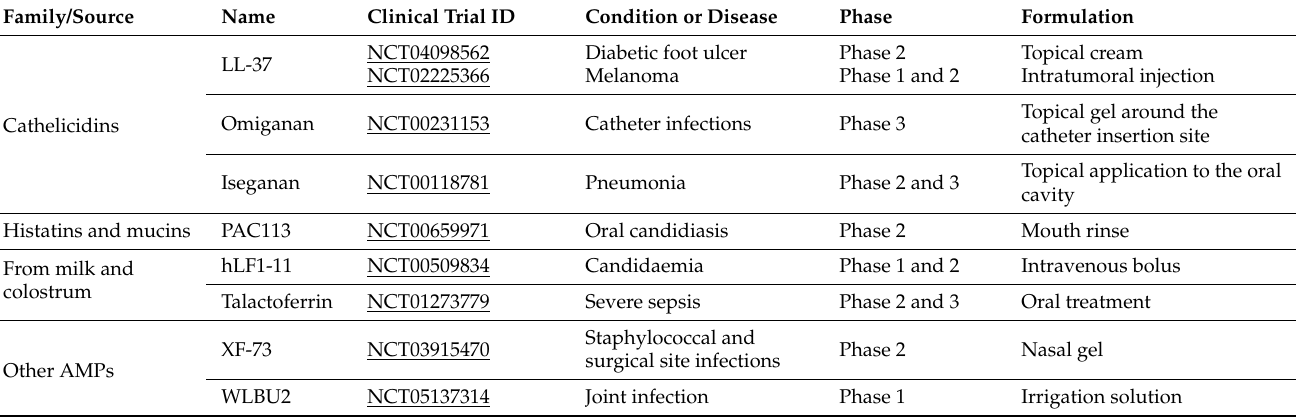
Table 3. Antimicrobial peptides (AMPs) that have been assessed in clinical trials and are major therapeutically relevant